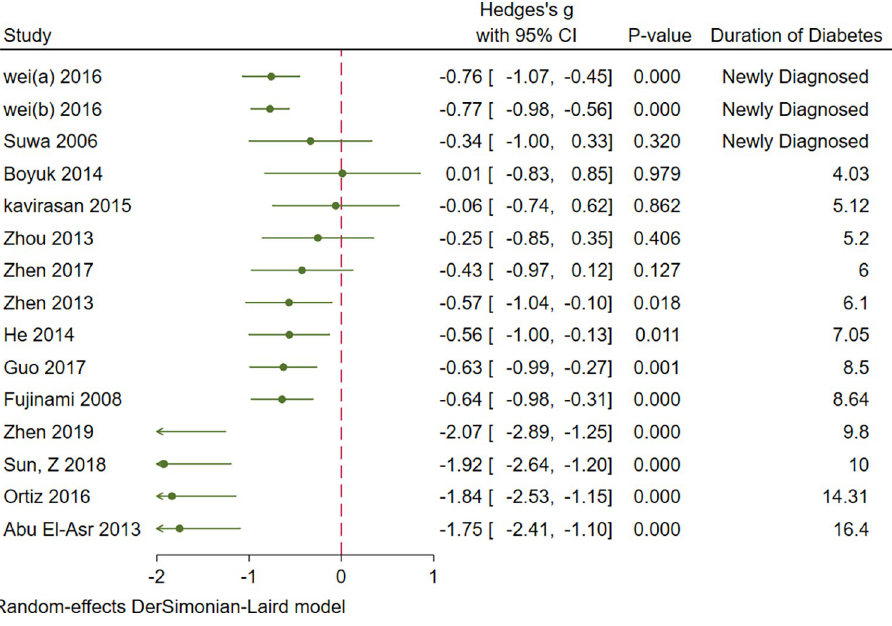
Fig 9. Cumulative meta-analysis of BDNF levels in patients with DM by the duration of the disease.